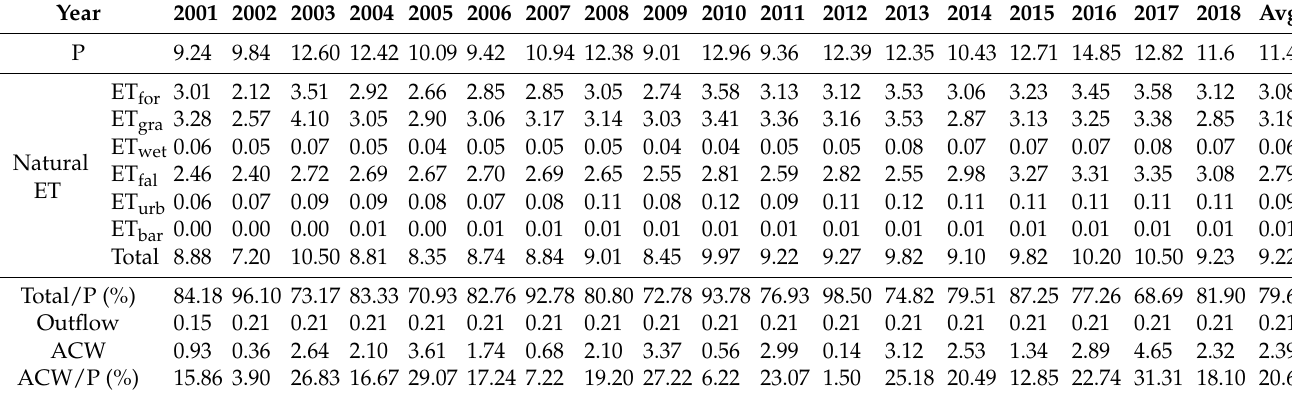
Table 4. Precipitation, natural ET, ACW, and outflow from the CTRYDRSD from 2001 to 2018 (10 9 m 3